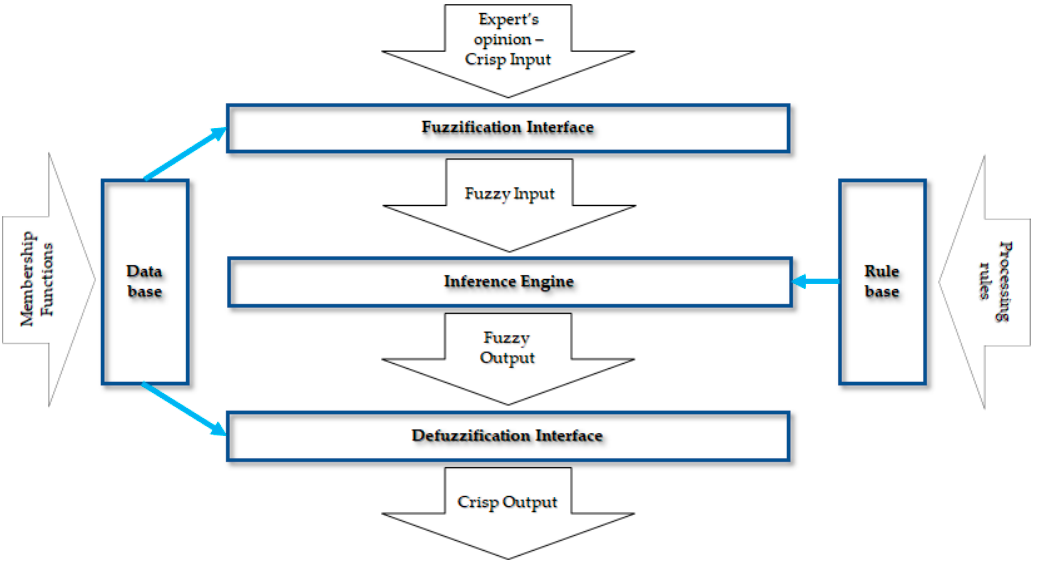
Figure 3. MAMDANI fuzzy model in the analyzed research problem.